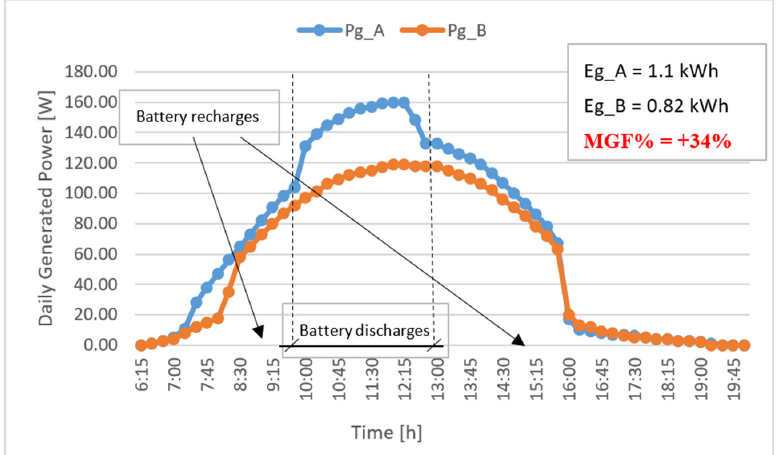
Figure 15. Daily Power generation curves, Pg_A and Pg_B, of the two prototypal PV generators A and B on an August 2021 cloudless day, together with the corresponding daily generated energy values, Eg_A and Eg_B, and the percentage major generation factor, MGF%. In this experiment, two identical shading plywood sheets were mounted on three PV cells of both homemade submodules of the PV generator A and B. On the submodule of the PV generator A, the battery control unit was activated while the bypass diode of the submodule of the PV generator B intervened early, and it remained in the conduction mode until the evening.